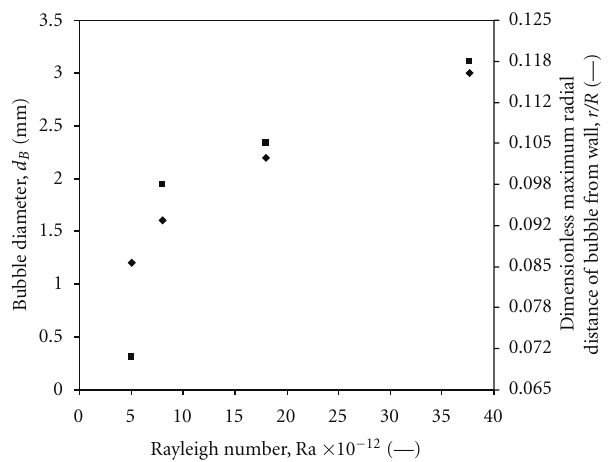
Figure 5: Variation of bubble diameter and maximum radial distance of bubble from the wall with Rayleigh number. (cid:2) radial distance from the wall (cid:3) bubble